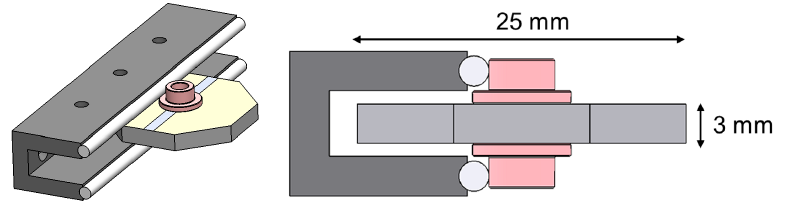
Figure 13. Perspective and end views of the vibrator–slider interface. The side surfaces of both eyelets were contacted tangentially to the alumina rods on the U-shaped slider. The distance between any of the two parallel side surfaces of the plate was 25 mm and the thickness was 3.0 mm.